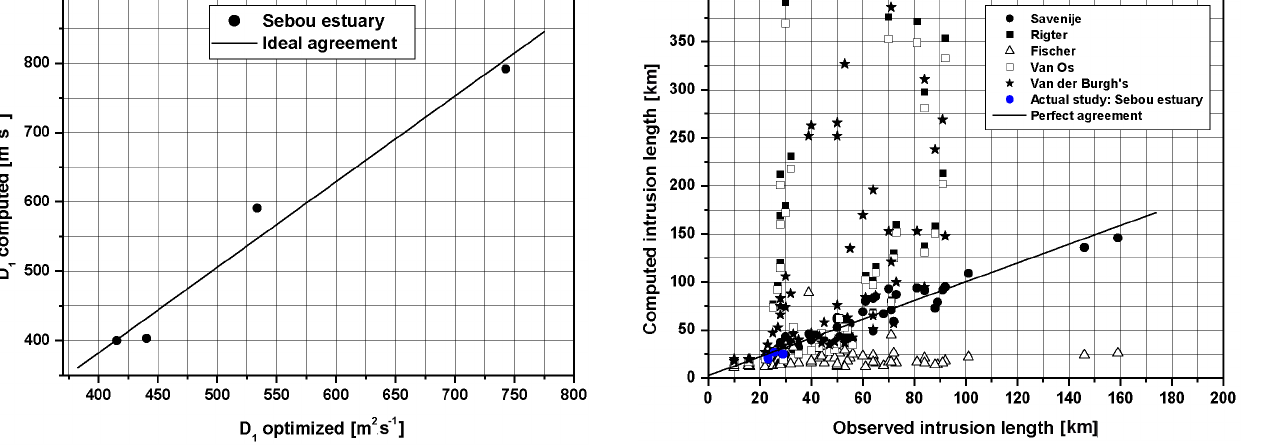
Figure 12. Comparison of computed and optimized dispersion D 1 coefficient at HWS in the spring–neap and the supermoon total lunar eclipse day tides.